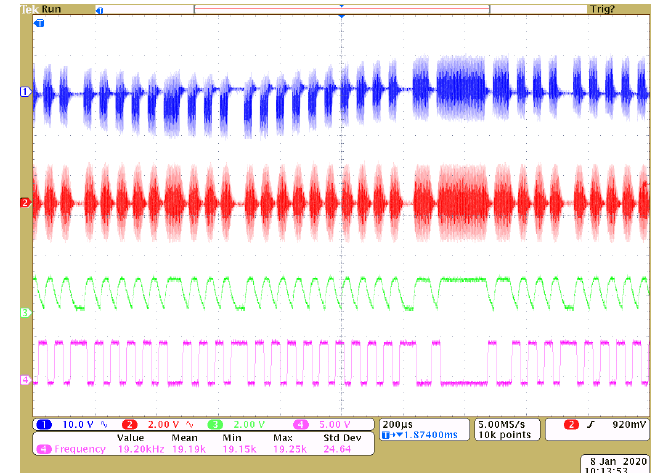
Figure 16. Practical waveforms on the transmitted ASK signal (blue), received Amplitude Shift Keying (ASK) signal (red), demodulated signal (green) and output digital signal